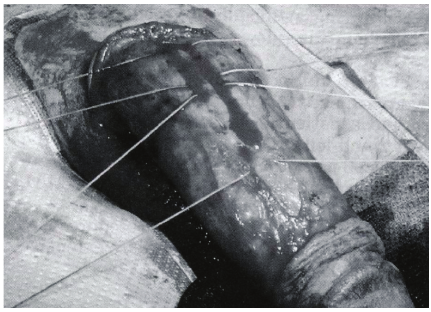
Figure 1: Penile deformity secondary to Peyronie’s disease.